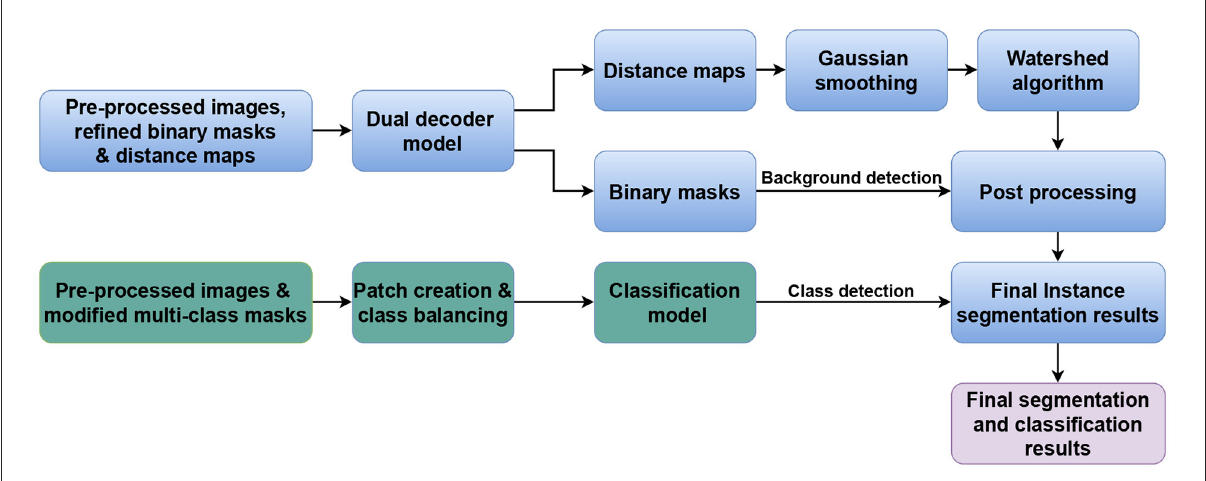
FIGURE1 Generic workflow of the proposed method. The blue and green parts represent the nuclei instance segmentation and nuclei classification components,